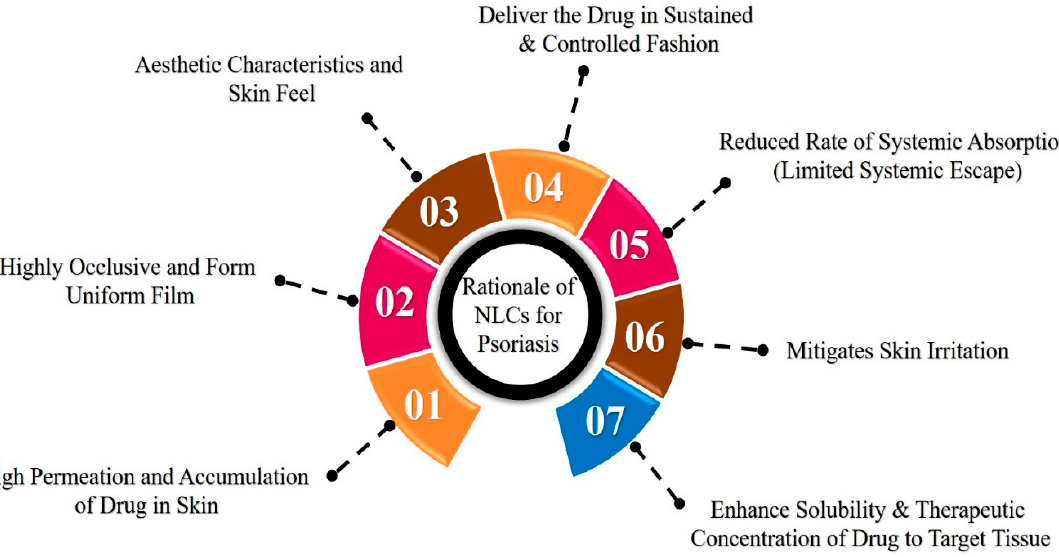
Figure 5. Rationale behind the selection of NLCs for the treatment of psoriasis disease .